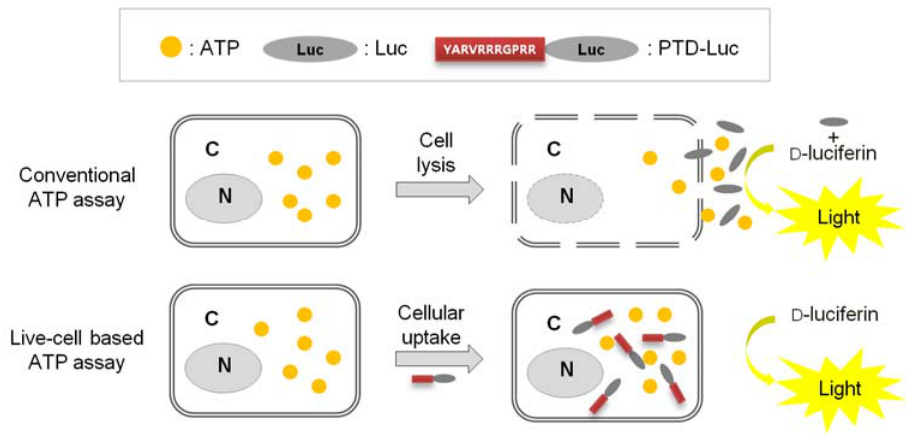
Figure 1. Schematic of the direct measurement of intracellular ATP using PTD-Luc in a live cell. Inset: PTD-Luc with 11 amino acids (YARVRRRGPRR) and Luc as a control. The conventional ATP assay requires cell lysis to release the cell contents, including ATP. By contrast, in the live-cell ATP assay, PTD-Luc can cross the cell membrane without perturbing the cell, enabling the direct measurement of the intracellular ATP content. C, cytosol; N,